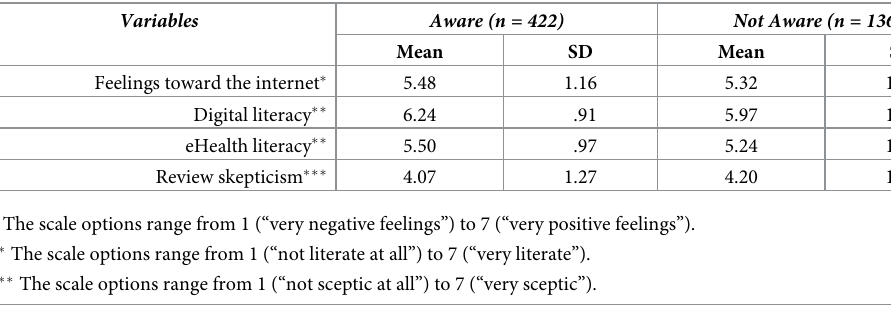
Table 3. Coherence of psychographic variables and general awareness regarding PRWs.